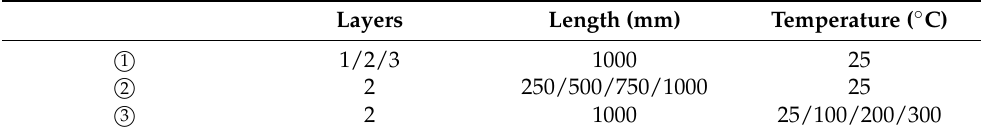
Table 2. Three groups of parameters of long coated damping